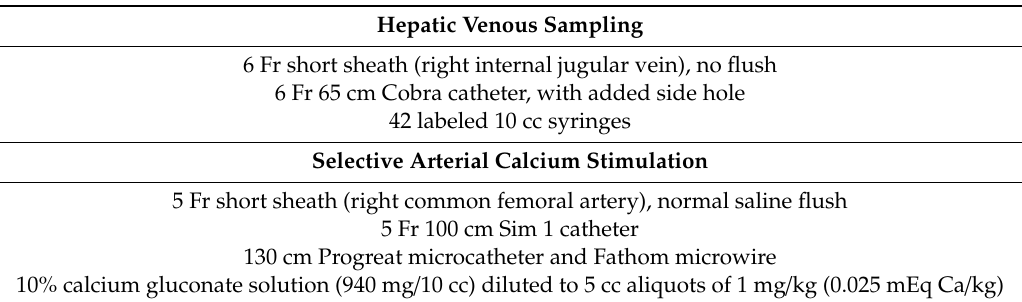
Table 2. Suggested